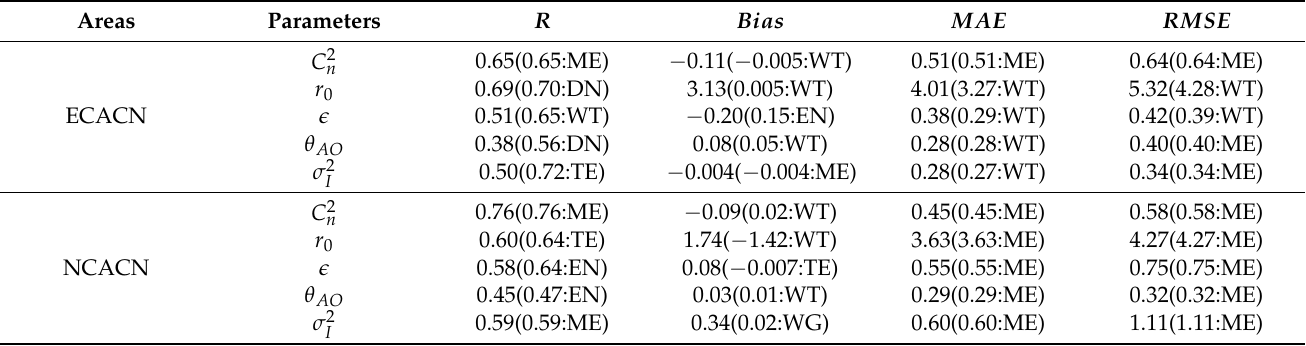
Table 6. Performance of MEP/ME against the best one (within parentheses) (the integrated astro- nomical parameters were calculated for the wavelength of light at λ = 550 nm. The values retain two decimal